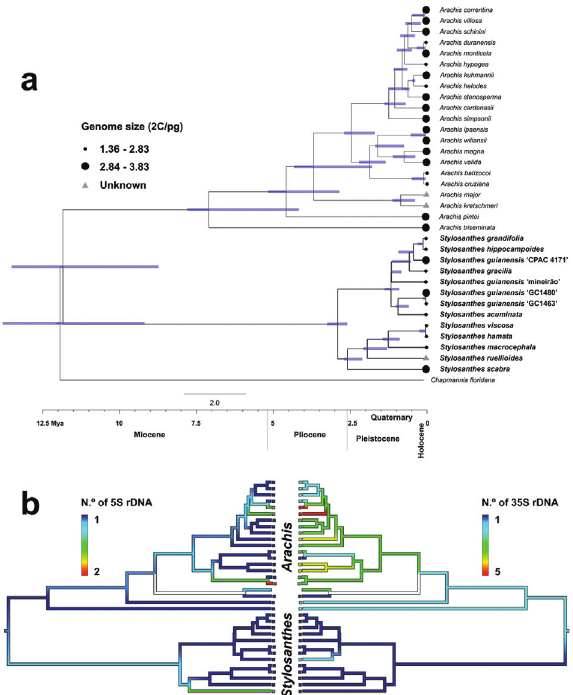
Figure 5 - Chronogram of Arachis and Stylosanthes species based on BEAST analysis using the plastid mat K and nuclear ITS combined datasets. Blue bars indicate 95% highest posterior density intervals. a , comparativeDNAcontentevolution,withsymbolsnexttoaccessionspro- portional to genome size. b , ancestral character estimation of number of rDNA sites along the branches and nodes of the phylogeny. The color of edgesinthetreerepresentsobservedandreconstructedvaluesforchromo- some number on the tree. Red colors correspond to relatively high num- bers of rDNA sites; whereas dark blue colors represent low number of ob- served and reconstructed rDNA